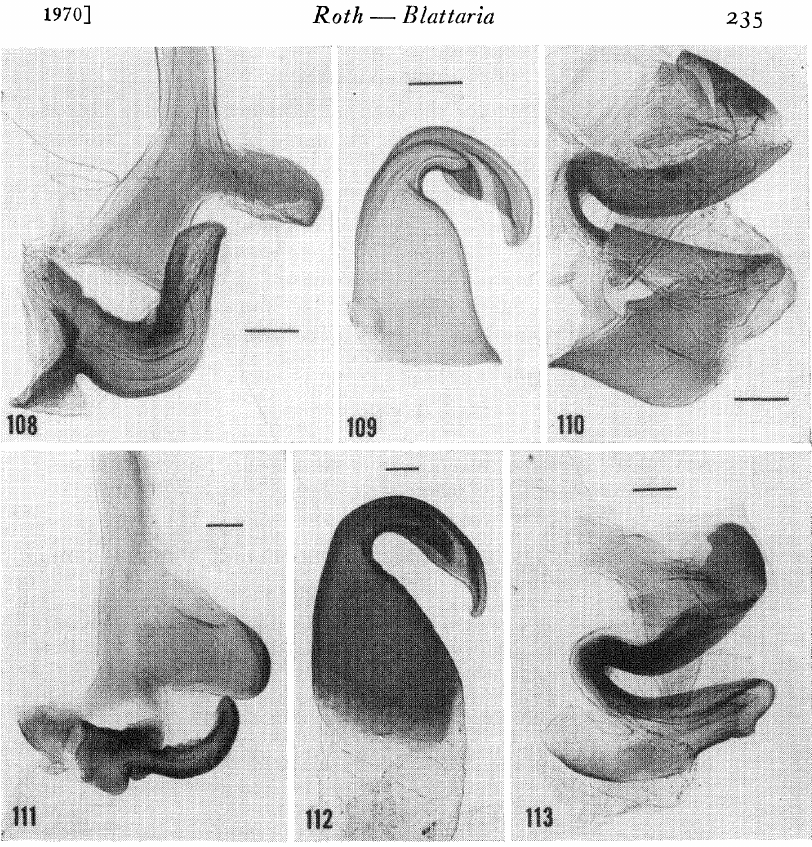
Figs. 108-113. 108-110. Tribonium sp. 108. (73 MCZ). (from adult shown in Fig. 20). 109-110. (31 MCZ). 111-113. (115 ANSP). Schlsto- peltis peculiaris. (from adult shown in Fig. 21). (scale 0.2